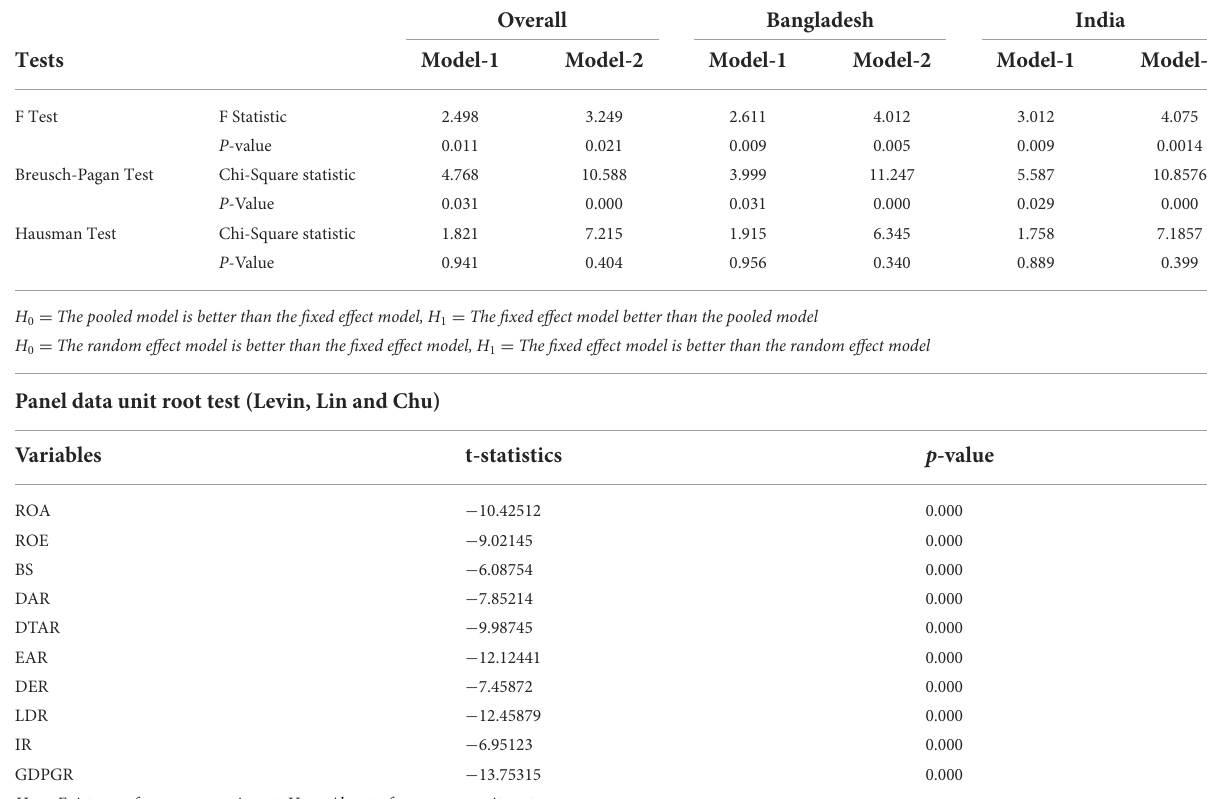
TABLE 3 Houseman test, Brush–Pagan Lagrange multiplier (LM), and Panel data unit root test, and result of F-test.